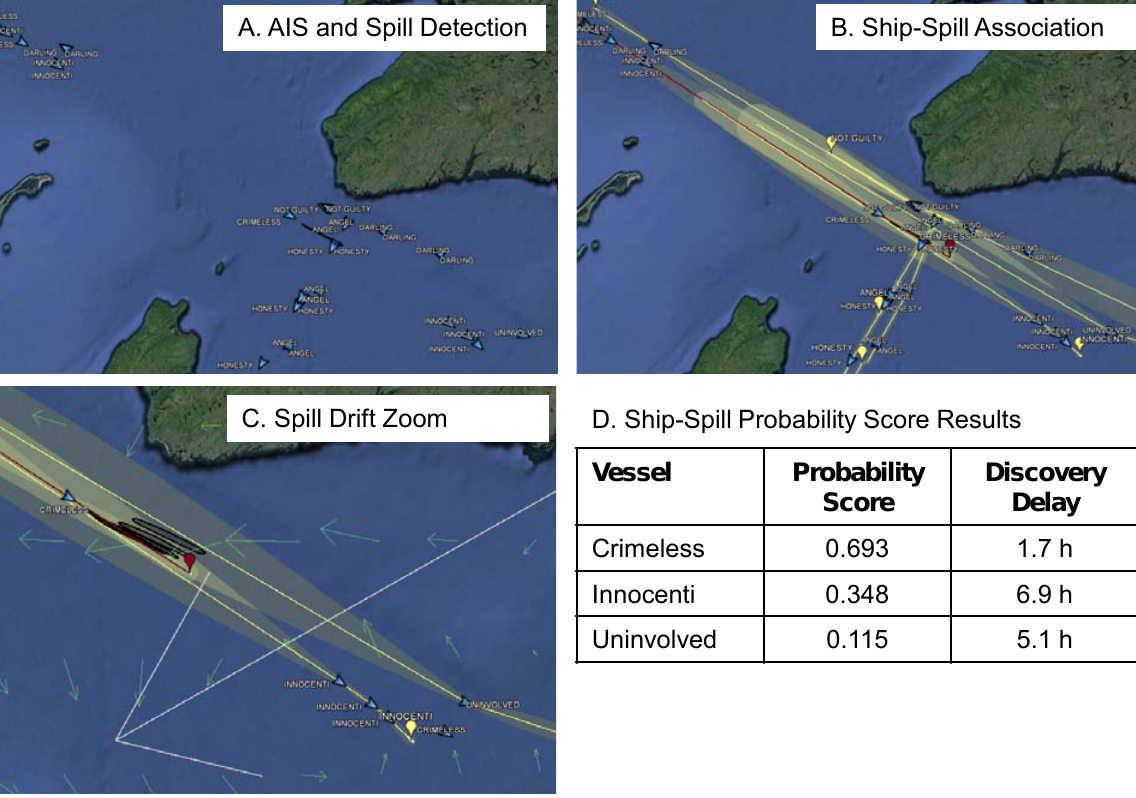
Figure 3 Ship-Spill Association Results for Test Case